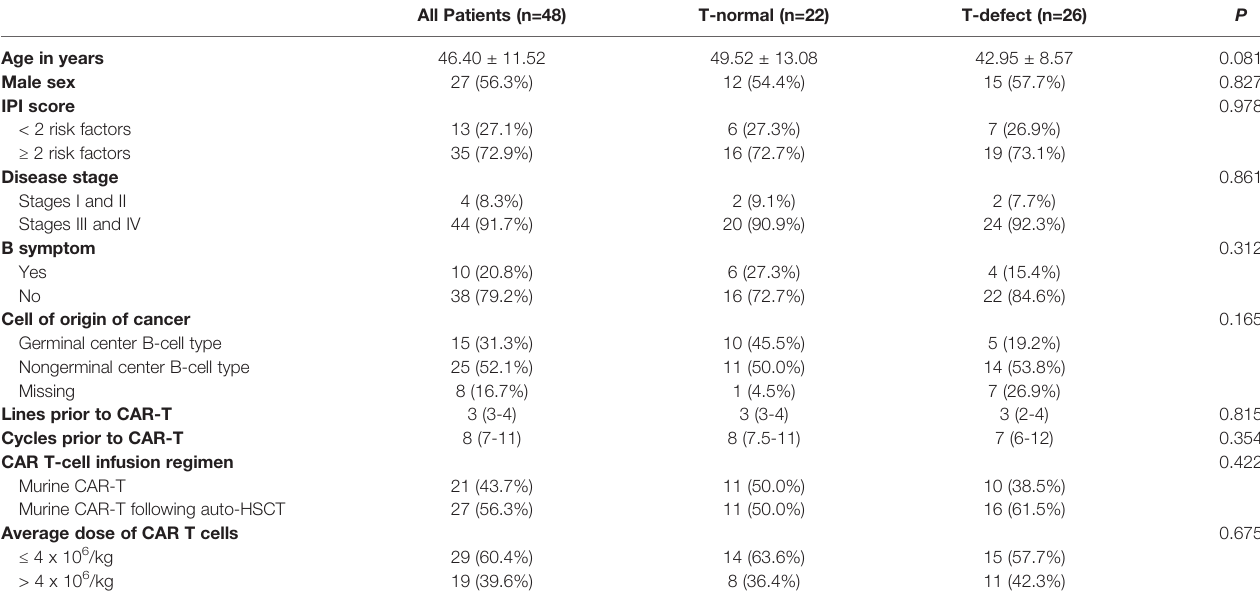
TABLE 1 | Baseline characteristics of patients with and without T-cell defects after CAR-T therapy. All Patients